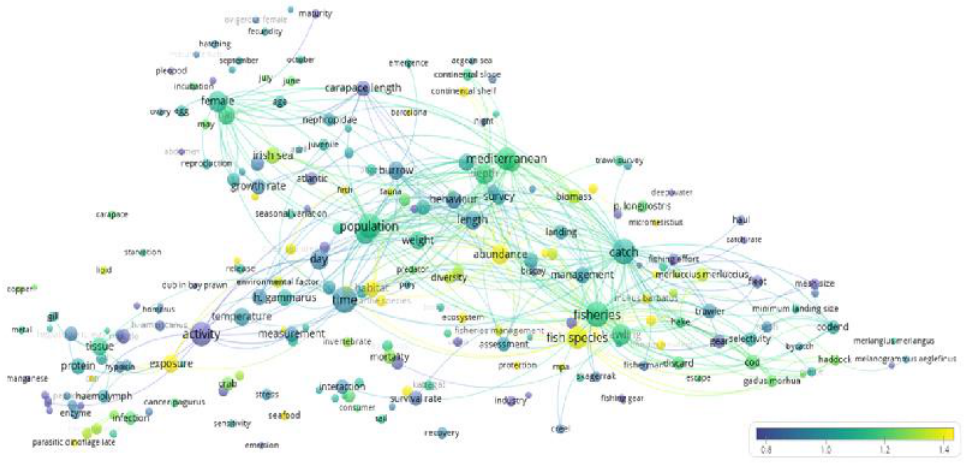
Figure 3. The citation map, indicating the frequency of term citation (i.e., the hotness of topics) within the surveyed bibliography. Table 2. The first 20 hot topic terms (i.e., with the highest citation score), sparse within the term score (average normalized citation) map of Figure 3. Some of those terms are not visible in the map due to labels overlapping, and therefore their positioning has been identified close to other visible terms of reference, with an indication of the belonging cluster (as per Figure 2).